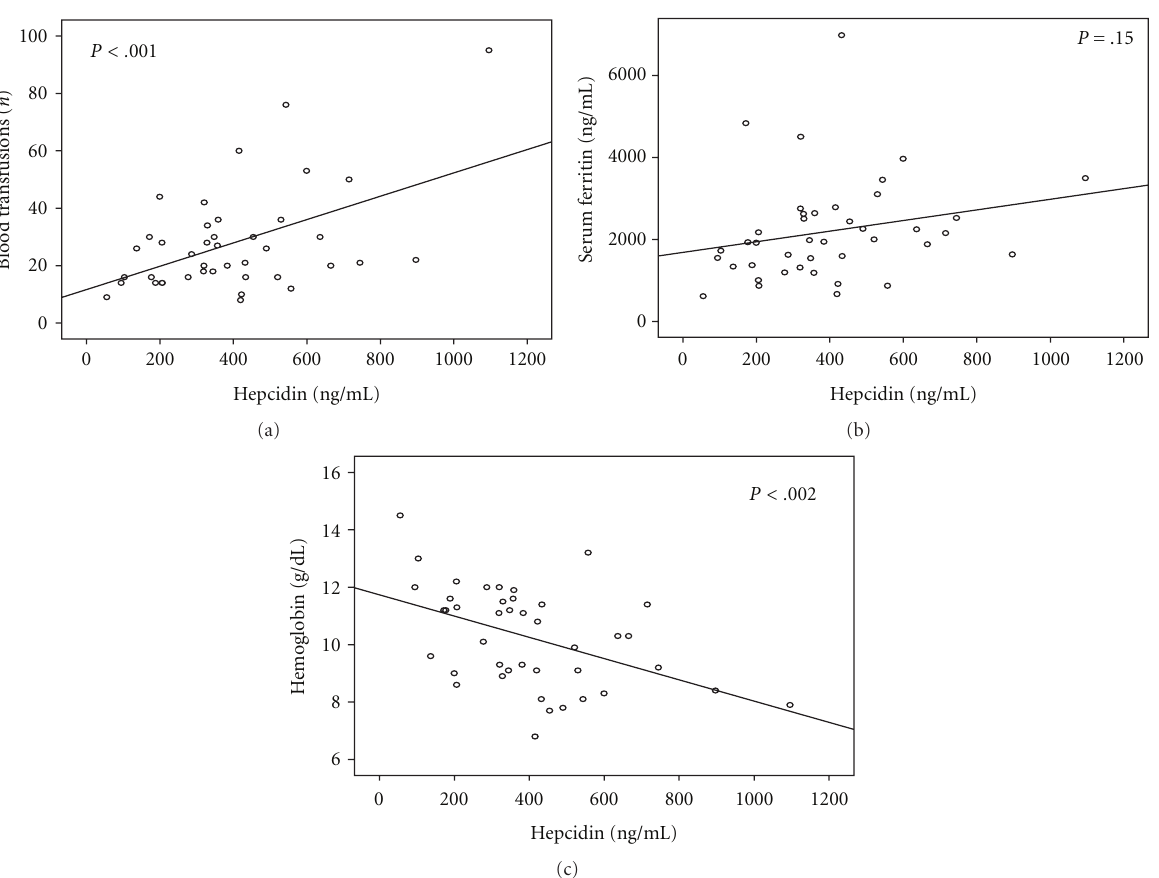
Figure 2: Correlation of serum hepcidin levels with number of blood transfusions (a), serum ferritin values (b), and hemoglobin levels (c) before